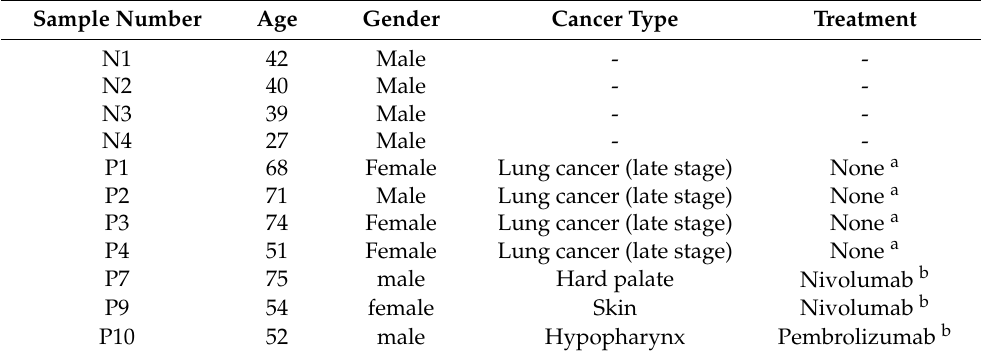
Table 1. Information on the enrolled